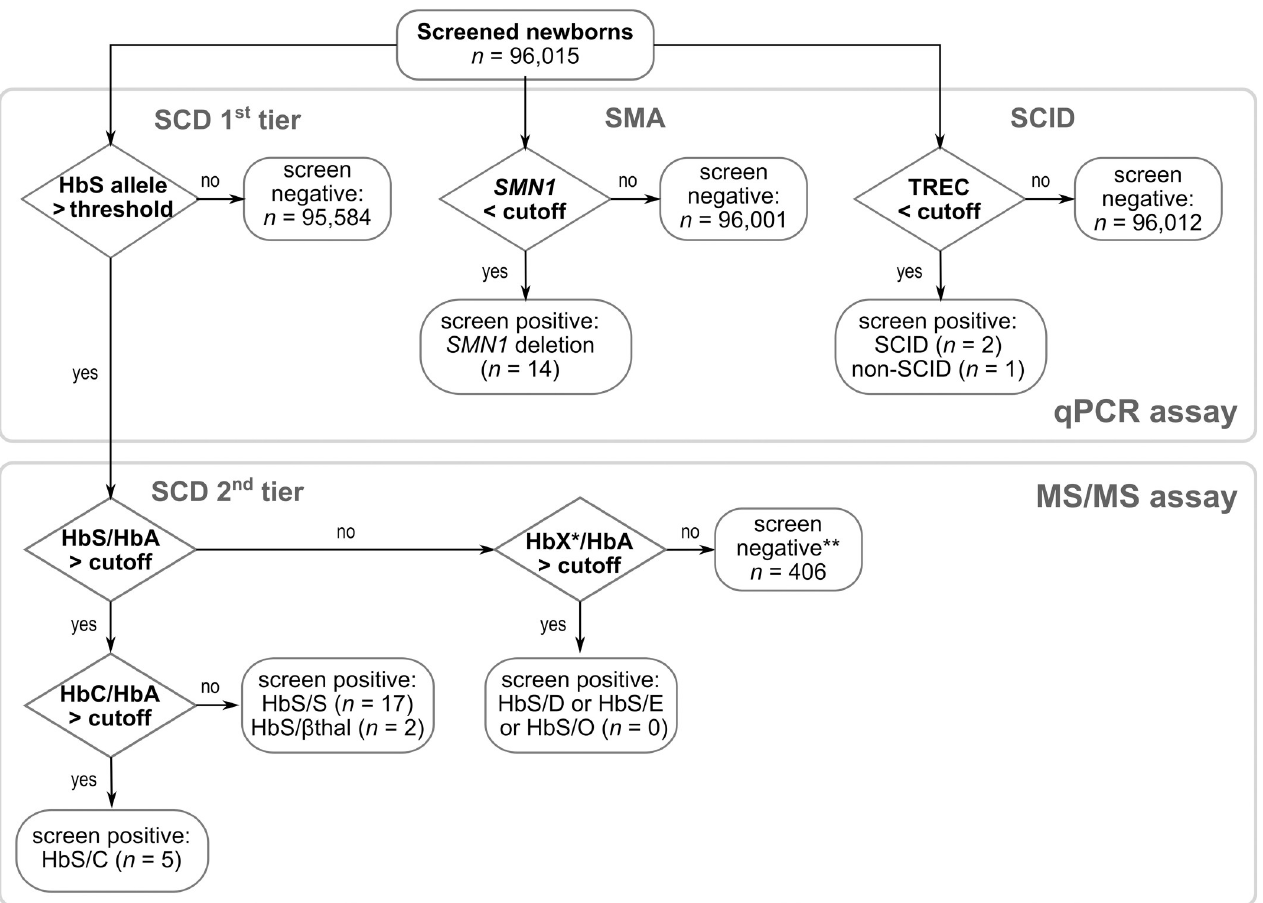
Fig 2. The combined SCID, SMA and SCD screening. Between July 1, 2021 and March 31, 2022, a total of 96,015 newborns were screened with a multiplex qPCR assay for SCID, SMA, and SCD. By the end of this period, a total of two SCID, one non-SCID syndromal lymphopenia,14 SMA, and 22 SCD patients were identified, � X = D Punjab , E, or O Arab ; �� one preterm patient was recalled. The figure was created with InkScape (v. 1.2).